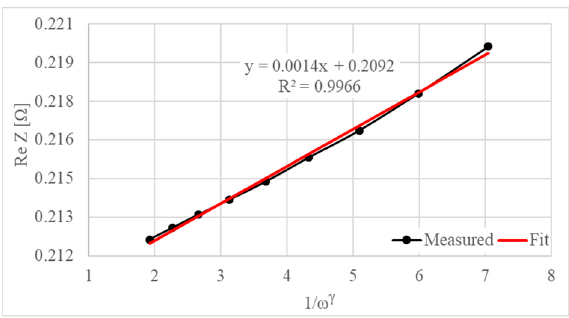
Figure 6. Fitting of the real part of the impedance data against 1/ ω γ within the 0.1 Hz–10 mHz frequency region to calculate the Warburg coefficient 𝜎′ .